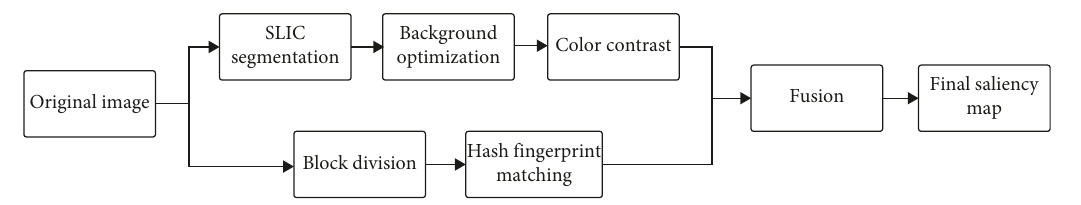
Figure 1: The framework of the proposed